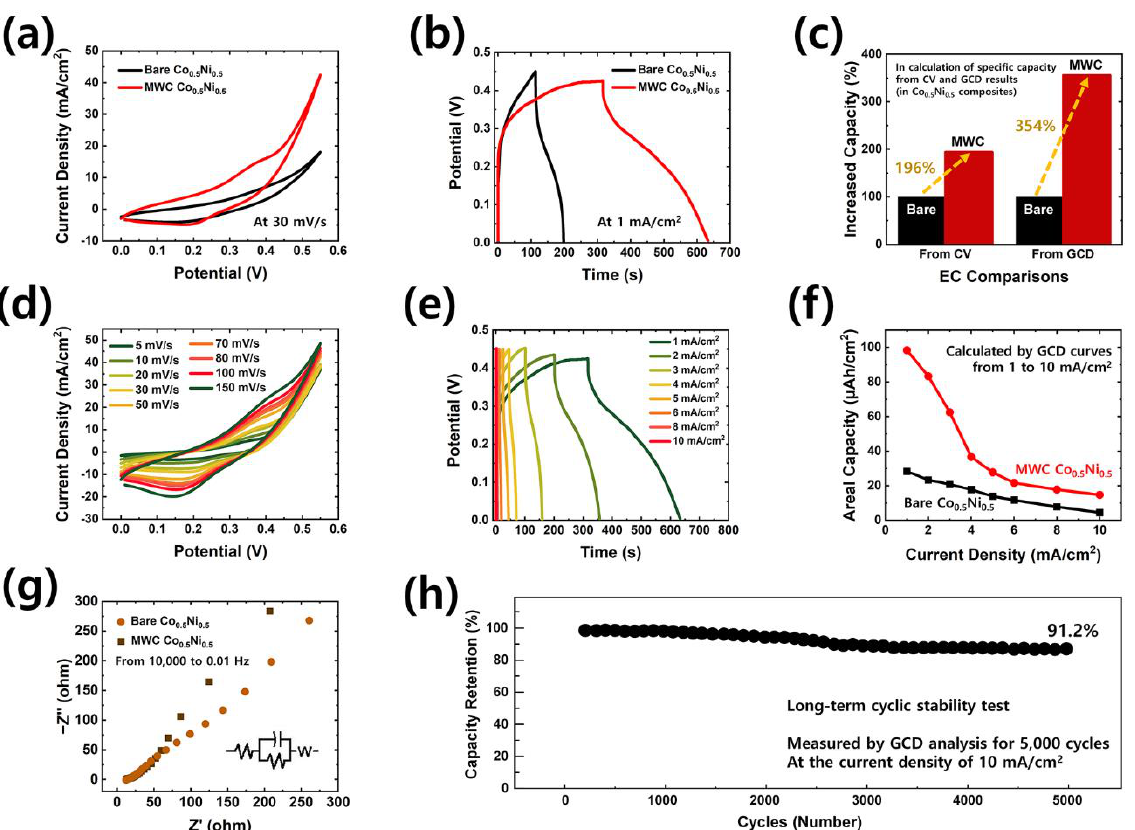
Table S1 (Supplementary Materials) of the Supporting Information. Due to the better charge storage capability of the MWC electrode compared to that of the bare electrode, a larger current density was obtained at the same potential bias. To investigate the charge transfer resistance and electrolyte resistance, EIS measurement (from 10,000 to 0.01 Hz) was performed, with results shown in Figure 4g. As is well known, a smaller diameter (at high frequencies) and a straight line with a higher slope (at low frequencies) may lead to better electrochemical performance. The R s / R ct values of bare and MWC electrodes are 12.92/3.85, and 12.73/1.83, respectively. The lower R s , and R ct values noticed in the case of the MWC electrode significantly boost the electrical conductivity and at the same time help to fasten the transfer of charges. For application to energy storage devices, this material must be subject to a long-term cycling test. Thus, the cycling stability of the MWC electrode was evaluated by GCD analysis at 10 mA/cm 2 , with results depicted in Figure 4h. Even after 5000 GCD cycles, capacitance values were approximately 91.2%, without any capacitance decay. This demonstrates the excellent electrochemical cycling stability of the electrode for long-term storage.